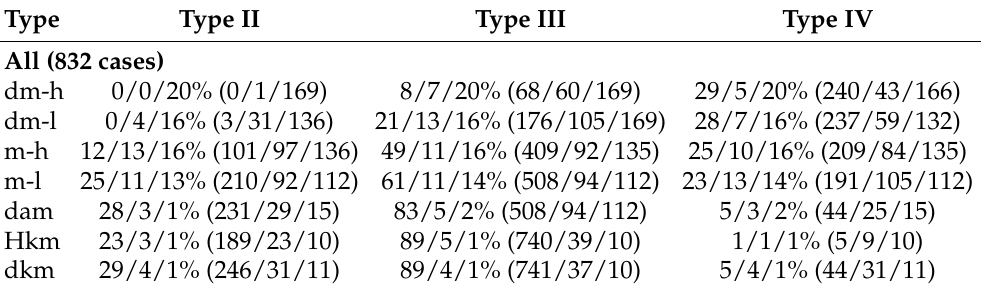
Figure 1. Plots of type II ( top ), III ( middle ) and IV ( bottom ) radio bursts for SC23 + 24 (denoted with ‘All’), normalized to 832 SEE events. For the color code see text. Table 2. Table of the occurrence of radio burst types II, III and IV in the different wavelength ranges over the entire time period (All). The results are shown as: visually identified/uncertain associations with observatory reports/data gaps, in % and the exact numbers are given in parentheses. The round-off error is (cid:46) 1%. 100% corresponds to 832